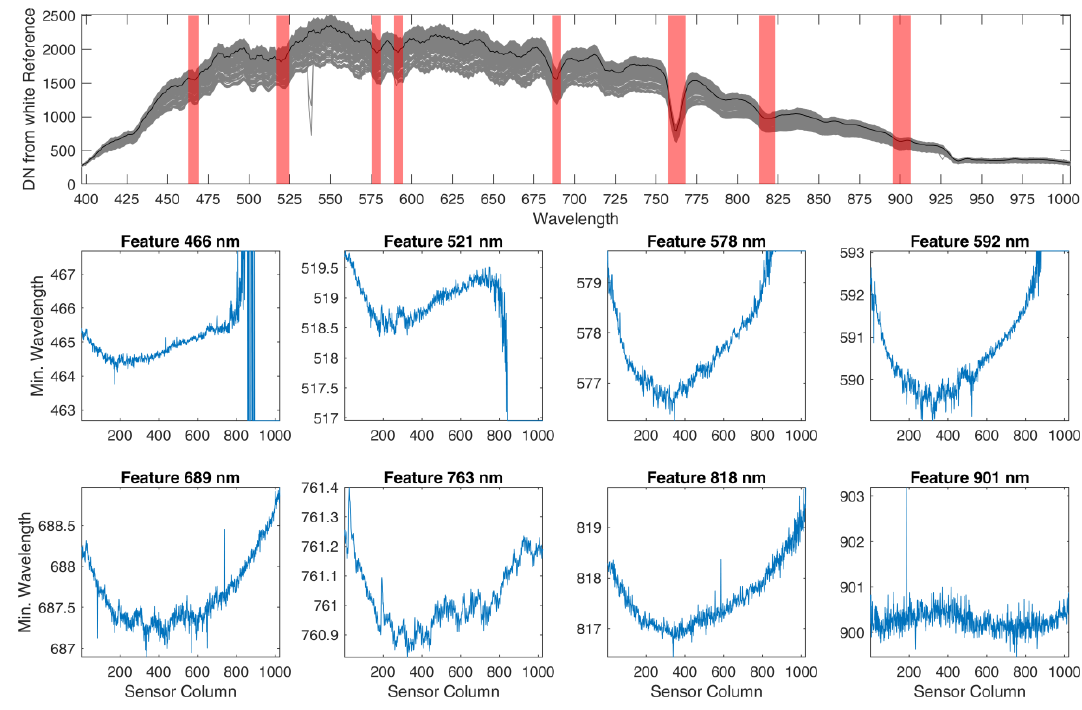
Figure 2. Analysis of sensor column dependent wavelength shifts. Top panel shows DNs of a measurement of sunlight reflected from a white reference panel (mean value in black and range given in gray). Eight wavelength positions with local minima are marked in red. The lower panels show the wavelength position of each minimum depending on the sensor column.